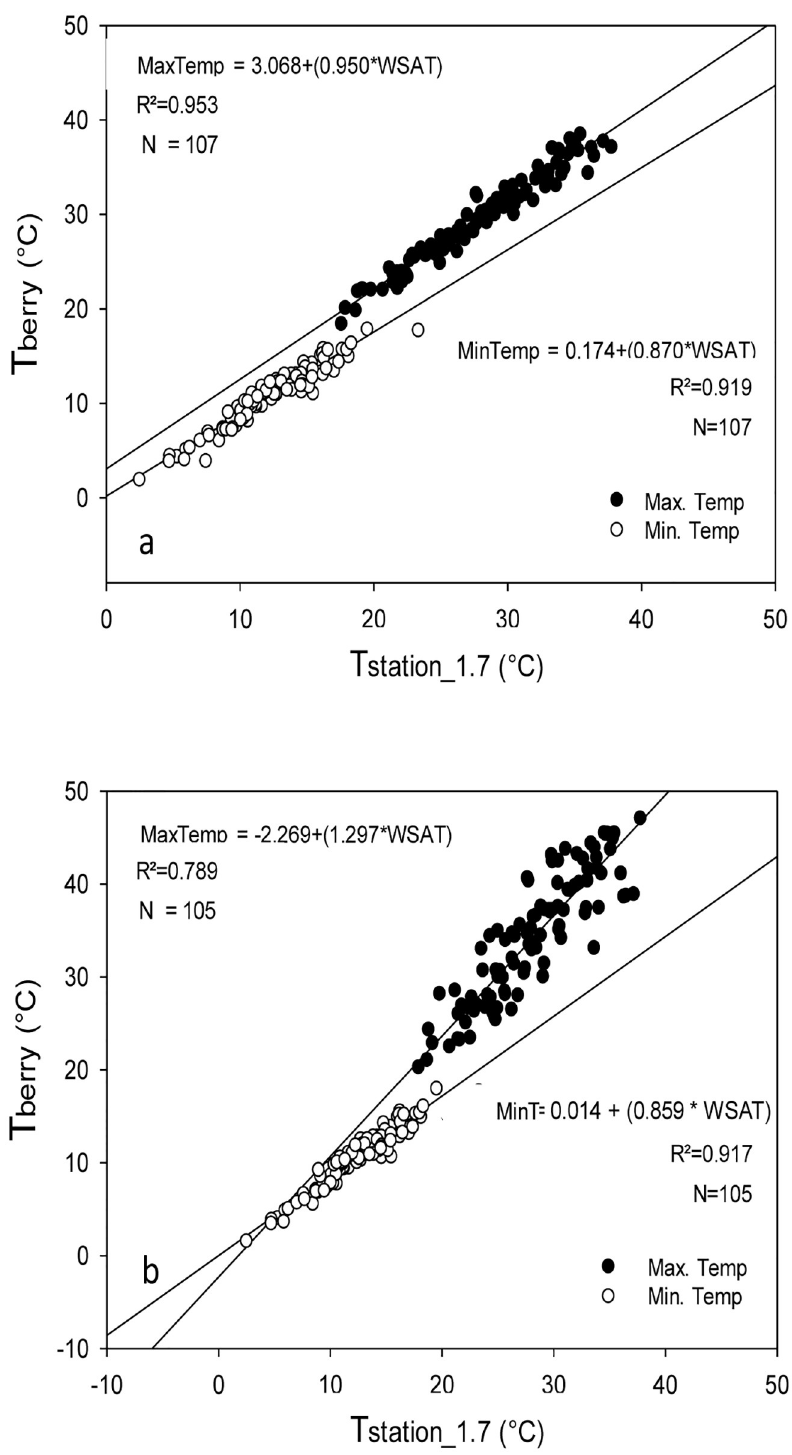
Fig 8. Linear regression comparing the daily maximum and minimum temperature measured within clusters (T berry ) facing east (a) and west (b) in the vineyard and at the weather station (T station_1.7 ).